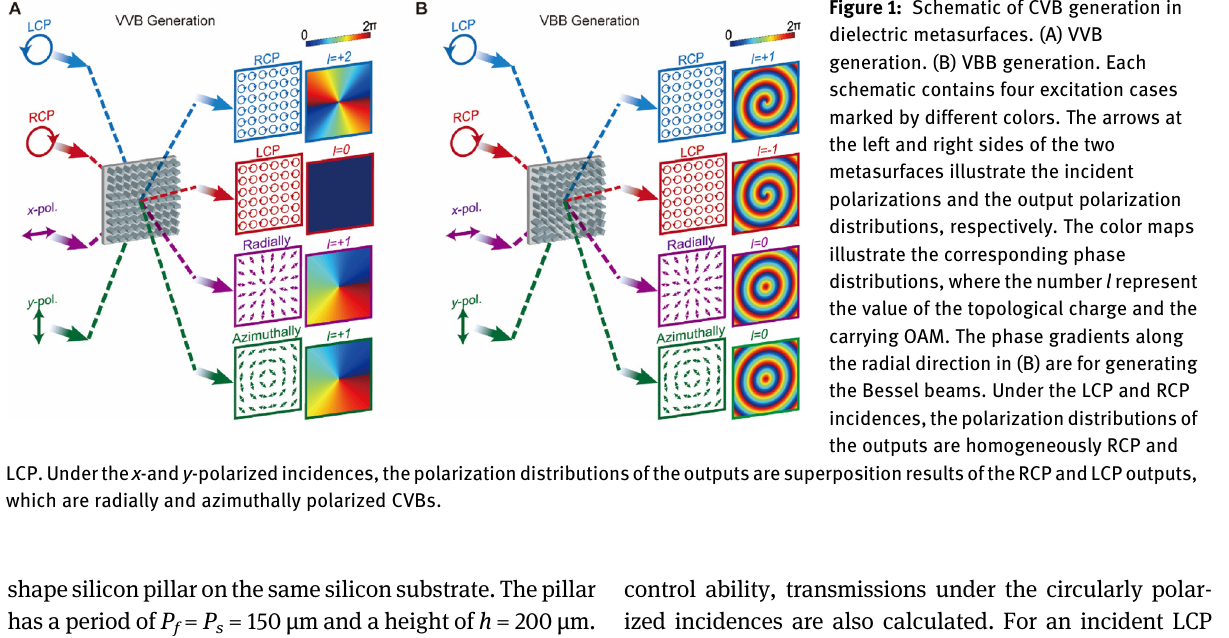
control ability, transmissions under the circularly polar- ized incidences are also calculated. For an incident LCP